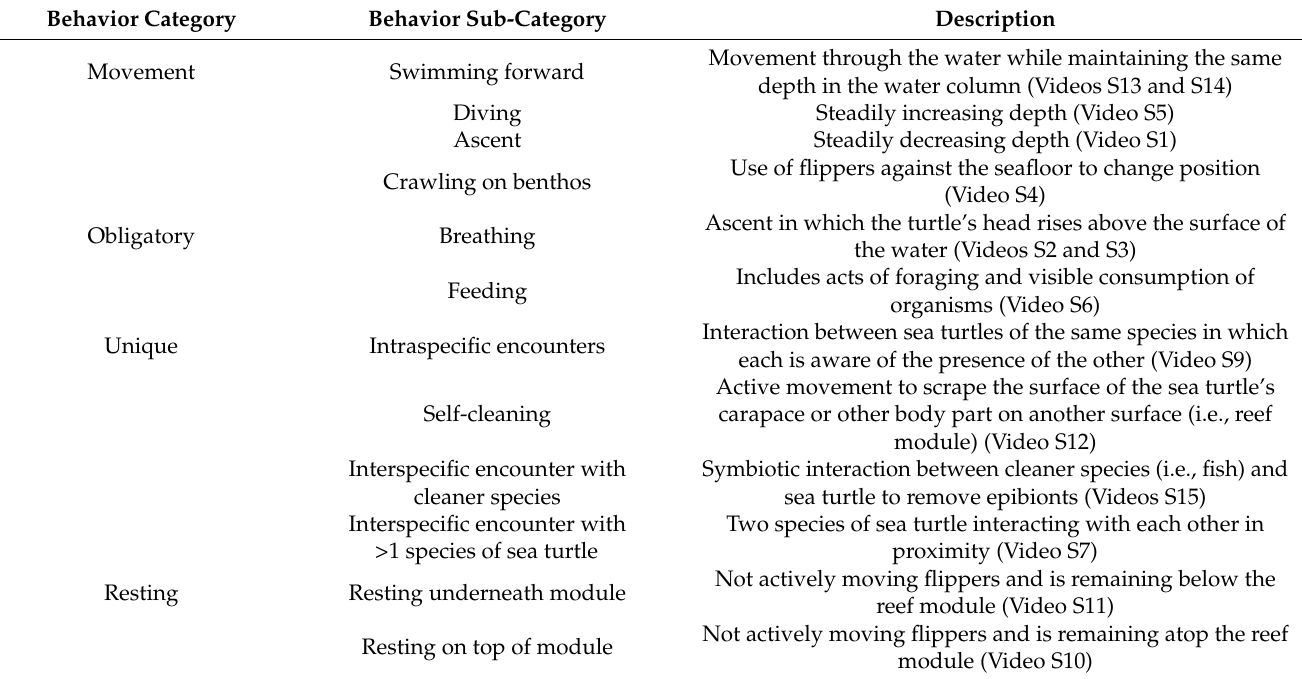
Table 1. Sea turtle behaviors and descriptions. Note: we include here reference videos